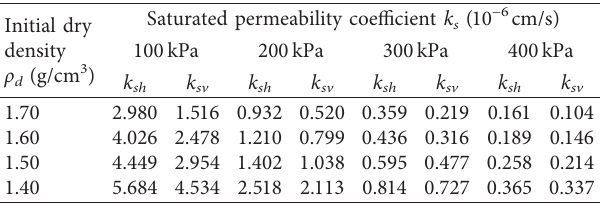
Table 7: Permeability coefficient of saturated compacted loess under K 0